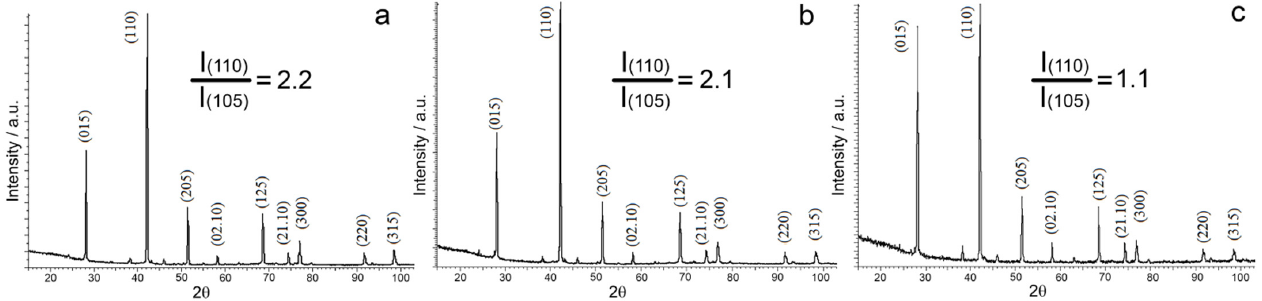
Figure 8. Evolution of diffraction peak intensity as a function of extrusion temperature: ( a ) 430 ° С , ( b ) 450 ° С , and ( c ) 470 ° С .